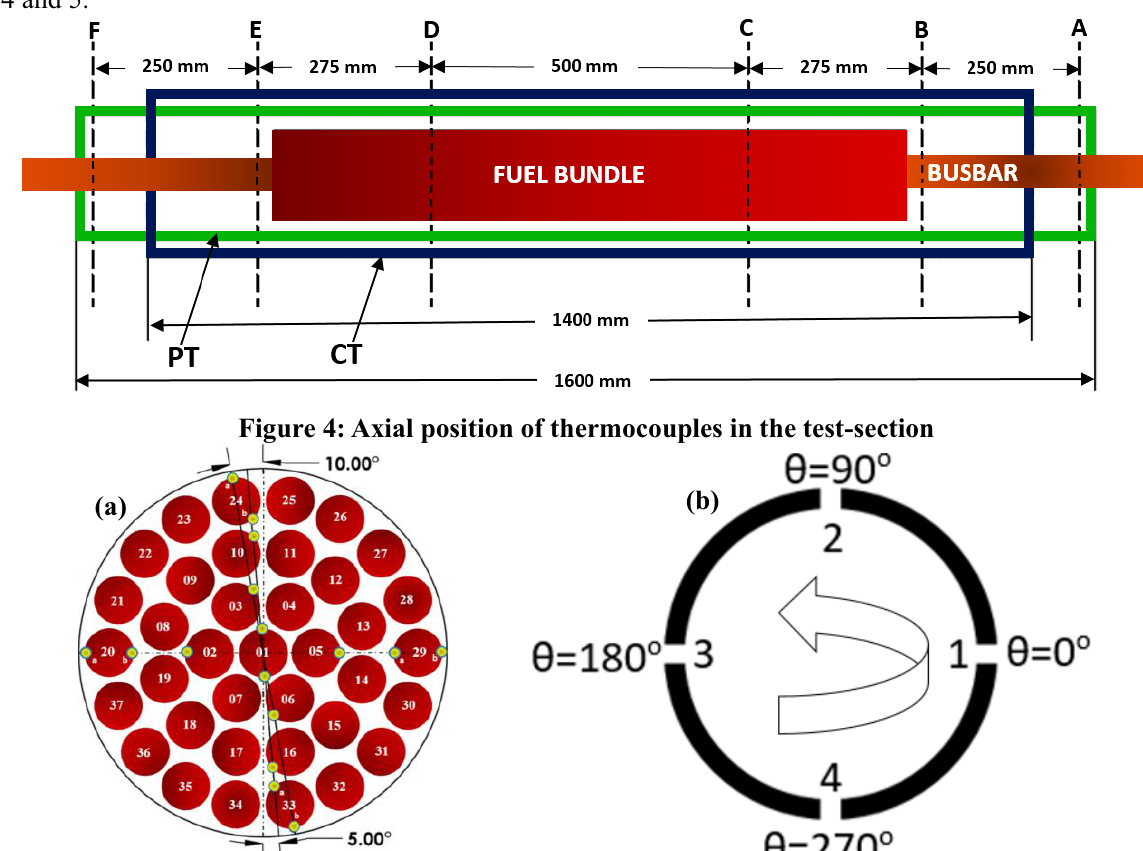
Figure 5: Circumferential position of thermocouples: (a) Fuel bundle (b) PT